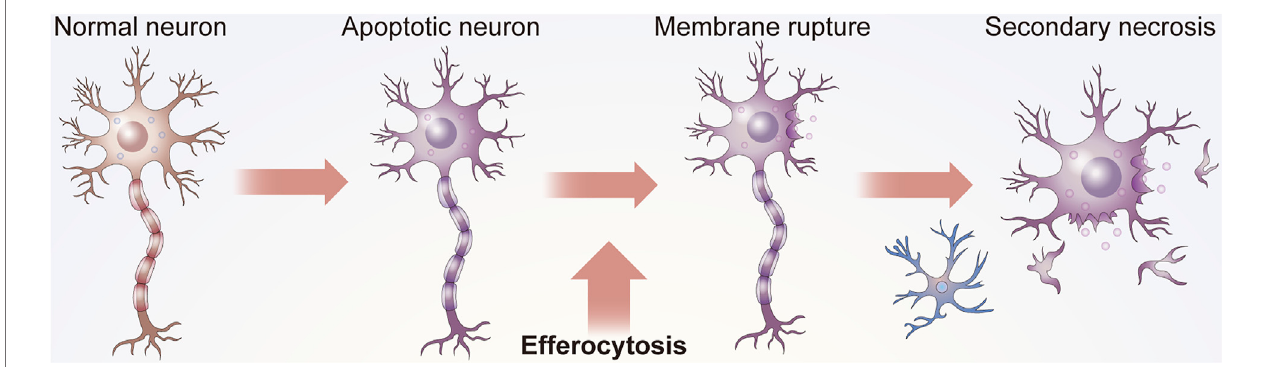
FIGURE1| Functionofefferocytosis.AsshowninPanel1,ef fi cientefferocytosiscancauseACs,usuallyapoptoticneuronsorglialcells,inthenervoussystemtobe removed by phagocytes to prevent secondary necrosis, the release of cytotoxic substances and damage to surrounding tissues. In addition, some efferocytosis cells present antigens.Efferocytes candistinguish thestateofengulfed cells,such aswhether theyare infected bybacteria orhave malignant changes,tosubsequently send appropriate signals to the immune system.